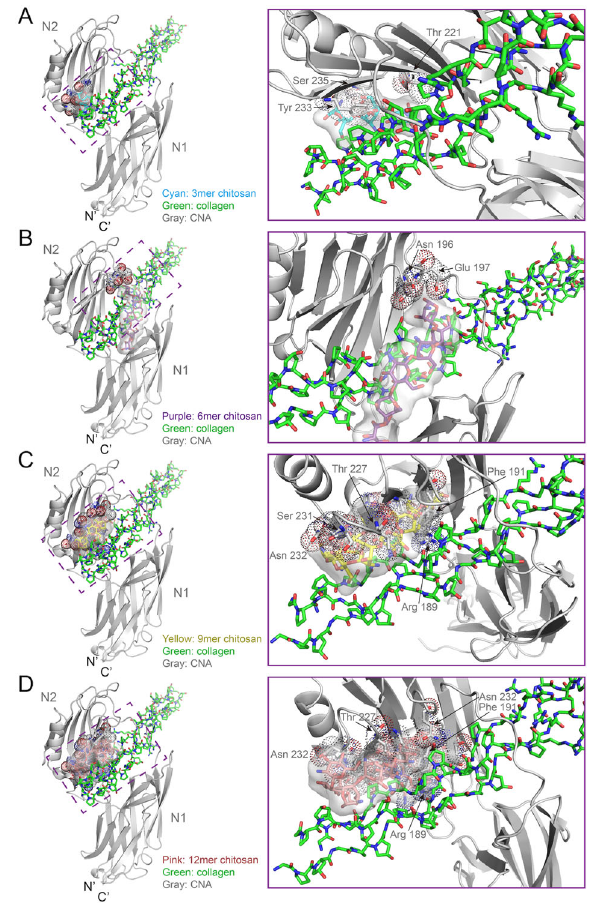
Fig. 5 The CNA N1 domain clashes to the best binding models of chitosan polymers with 3mer ( A ), 6mer ( B ), 9mer ( C ), or 12mer ( D ), respectively. Views of the detail clashes are shown in the right frames. N ′ and C ′ represent the N termini and the C termini of the CNA protein. The feature residues are shown as ball-and-stick and dot models. The chitosan polymers are shown as ball-and-stick and transparency surface models, colored cyan (3mer), purple (6mer), yellow (9mer), and pink (12mer), respectively. The synthetic collagen peptide is colored green (PDB: 2F6A). The CNA protein is colored gray (PDB: